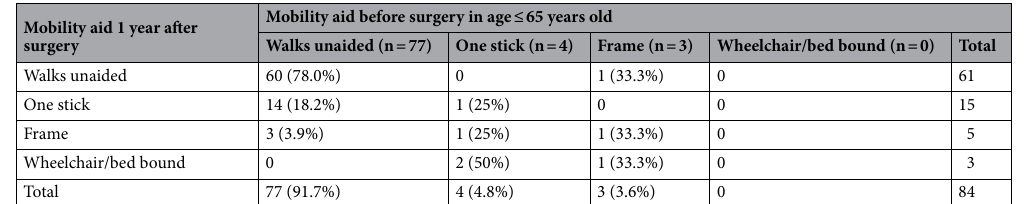
Table 4. Mobility changes of patients (age 65 years old or less) before and 1-year after surgery.